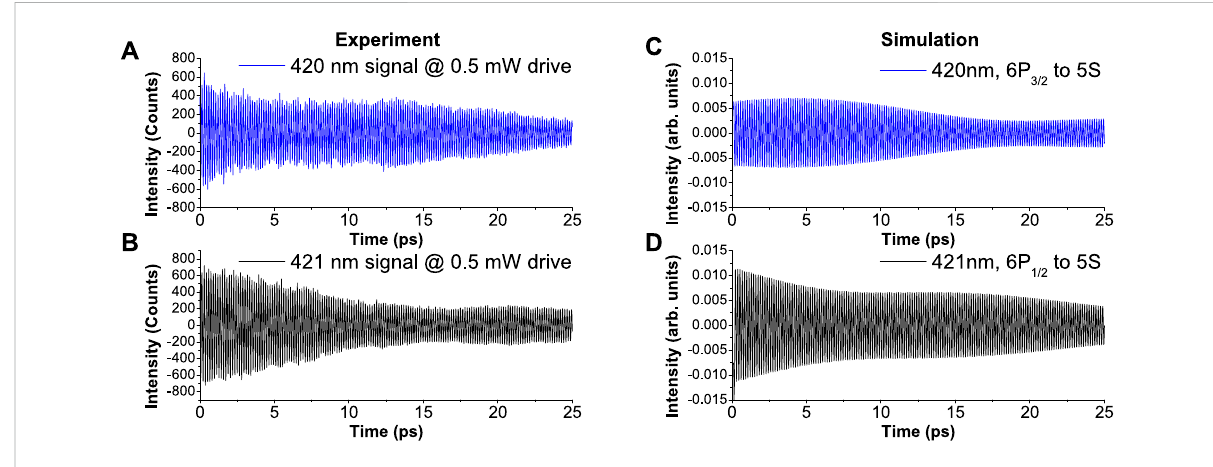
FIGURE 3 Slowvaryingenvelopesofthebeatsof420and421 nmsignals. (A) Blueand (B) blackareexperimentaldataafteran FFThigh-pass fi lteringused to remove the DC and exponential decay components from the raw data. (C) Blue and (D) black are numerical simulations for the corresponding transitions to (A) and (B) , both labeled with wavelength and color-coded to match the experimental